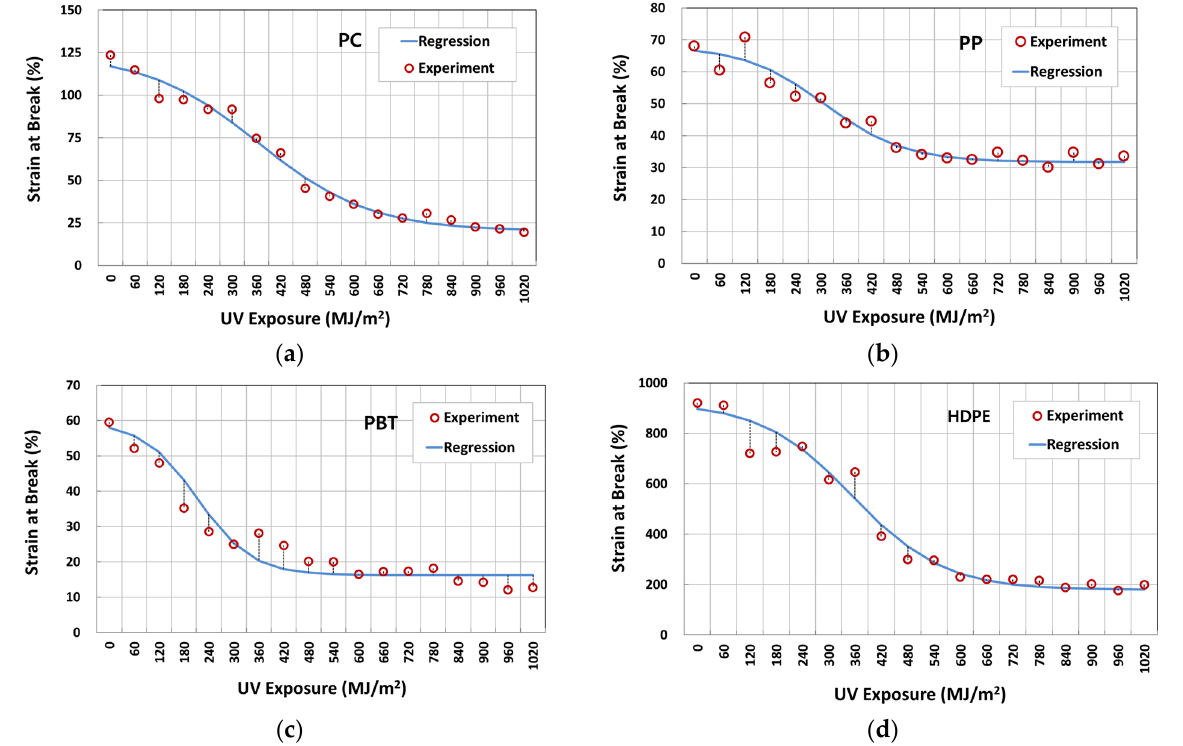
Figure 13. Fracture strain data and logistic regression results of four polymers during the 4-year weathering test: ( a ) PC; ( b ) PP; ( c ) PBT; and ( d ) HDPE.